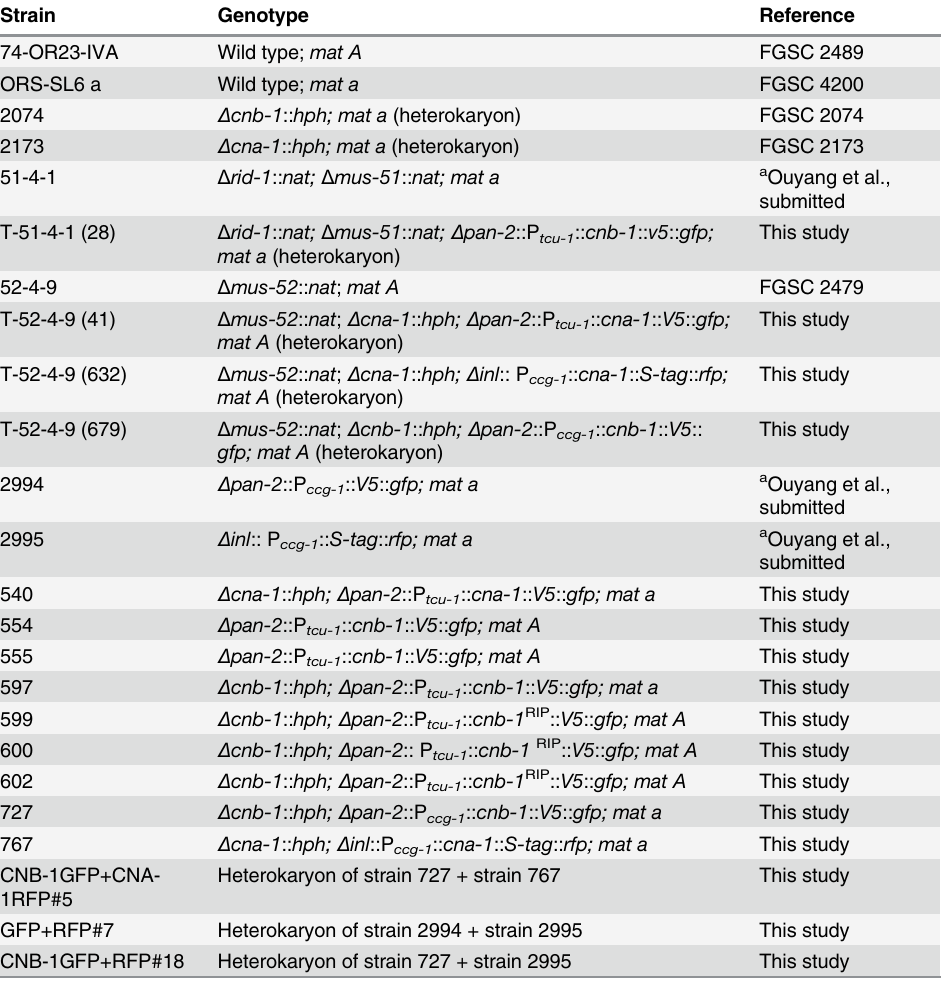
Table 1. Neurospora crassa strains used in this study.